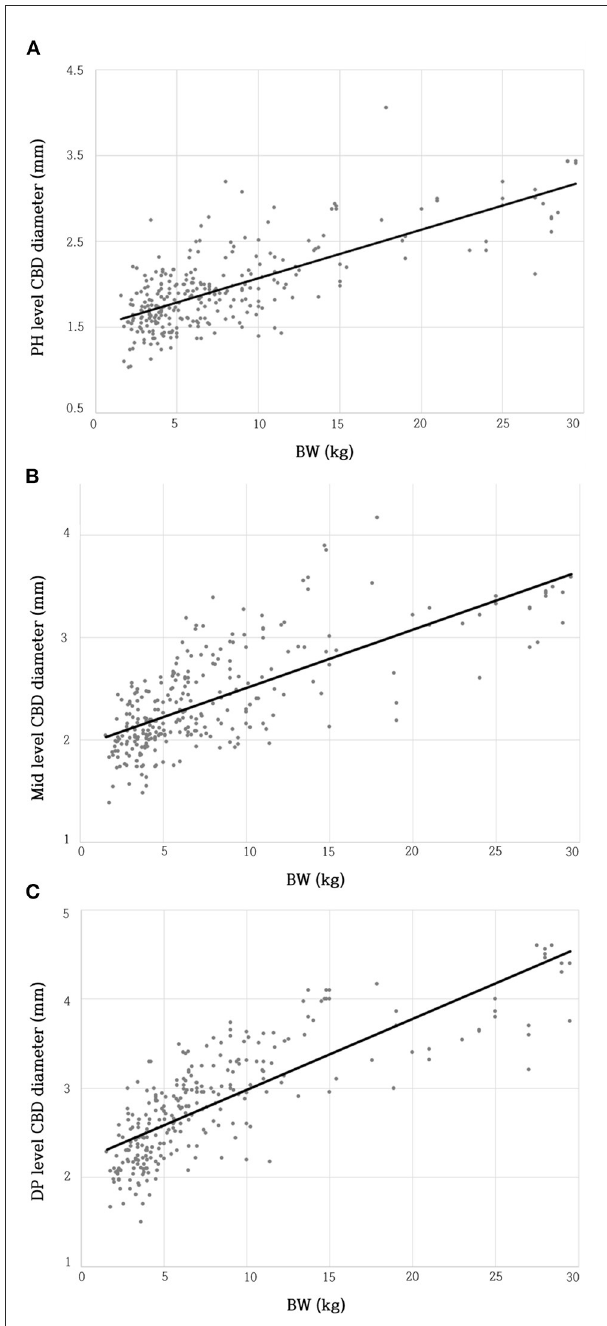
FIGURE3 Relationship between BW and CBD diameter at PH level (A) , Mid-level (B) , and DP level (C) . There were moderate linear positive correlations between BW and CBD diameter at each level. BW, body weight; CBD, common bile duct; DP, duodenal papilla; Mid, mid-portion; PH, porta hepatis.